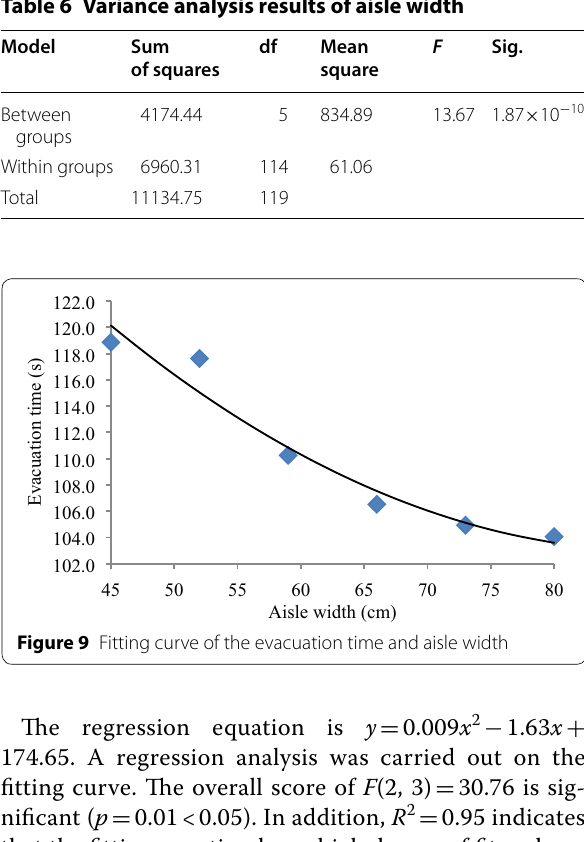
The regression equation is y 174.65. A regression analysis was carried out on the fitting curve. The overall score of F (2, 3) nificant ( p 0.01 < 0.05). In addition, R 2 = that the fitting equation has a high degree of fit and can evacuation time.